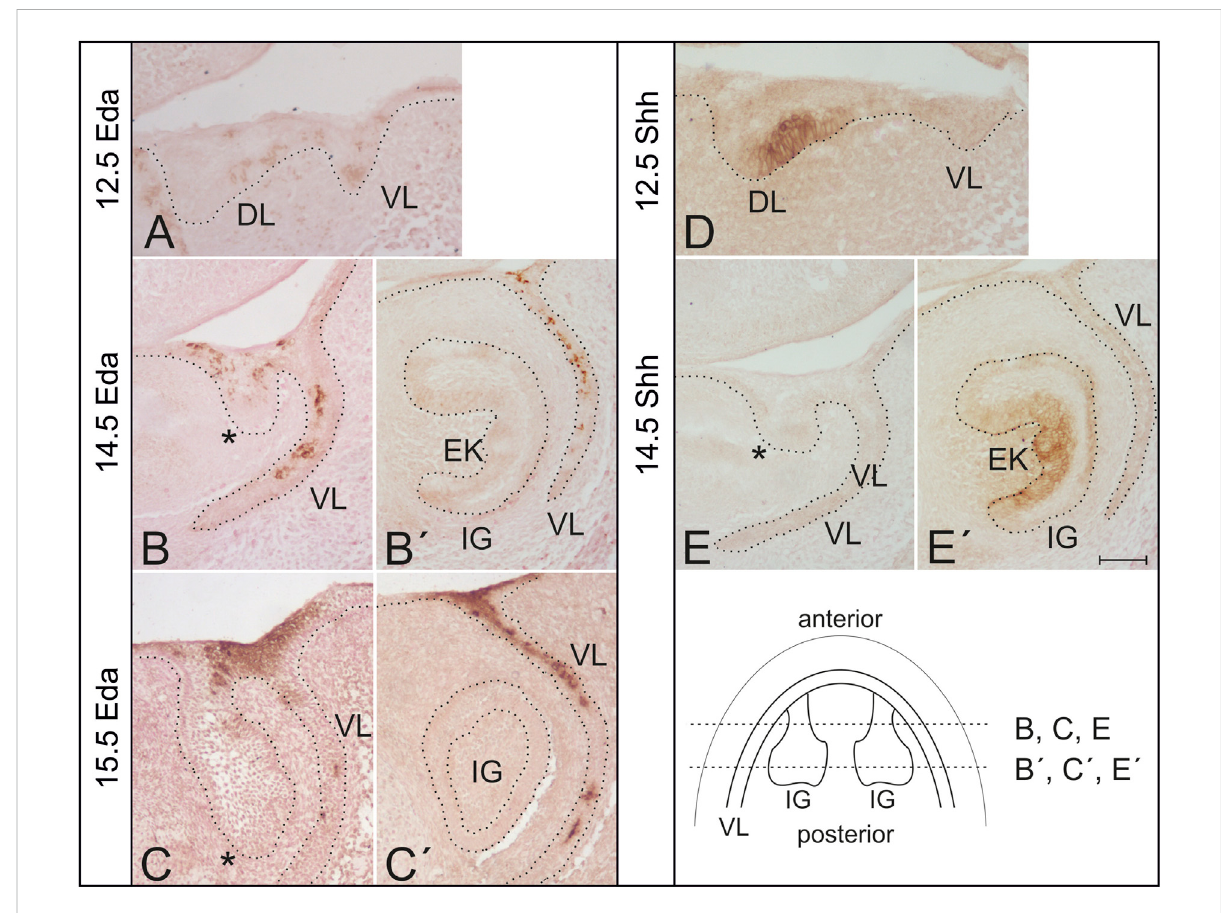
FIGURE 1 Expression of Eda and Shh protein in the developing mouse incisor in wild type mice. (A) Eda expression was detected using immunohistochemistry in the dental lamina (DL) as well as in the vestibular lamina (VL) in the anterior area of the mandible at ED12.5. (B,C) At later stages, Eda protein was detected in the anterior super fi cial area of the oral epithelium interconnecting the tooth germ with the VL, at the base of the incisor germ (asterisk). (B 9 ,C 9 ) No Eda protein expression was detected in the functional incisor germ (IG). Enamel knot (EK) detectable at ED14.5 was Eda negative. Eda expression was detected also in the adjacent vestibular lamina externally to the dental epithelium at more advanced stages of the development (B 9 ,C 9 ) . In contrast to Eda, Shh protein expression was detected using immunohistochemistry at the labial side of the dental thickening between DL and VL in the anterior area of the mandible at ED12.5. (D) Shh protein expression is typically absent in the anterior region at the base of the incisor germ at ED14.5 (E) . However, Shh expression is detectable in the enamel knot of the incisor germ and it is already expanding in the inner dental epithelium at this stage of the development (E 9 ) . Schematics shows location of histological sections (B,B 9 ,C,C 9 ,E,E 9 ) in the incisor regions of more advanced mandibles. Dotted line delimits the epithelium in the sections. Bar indicates 100